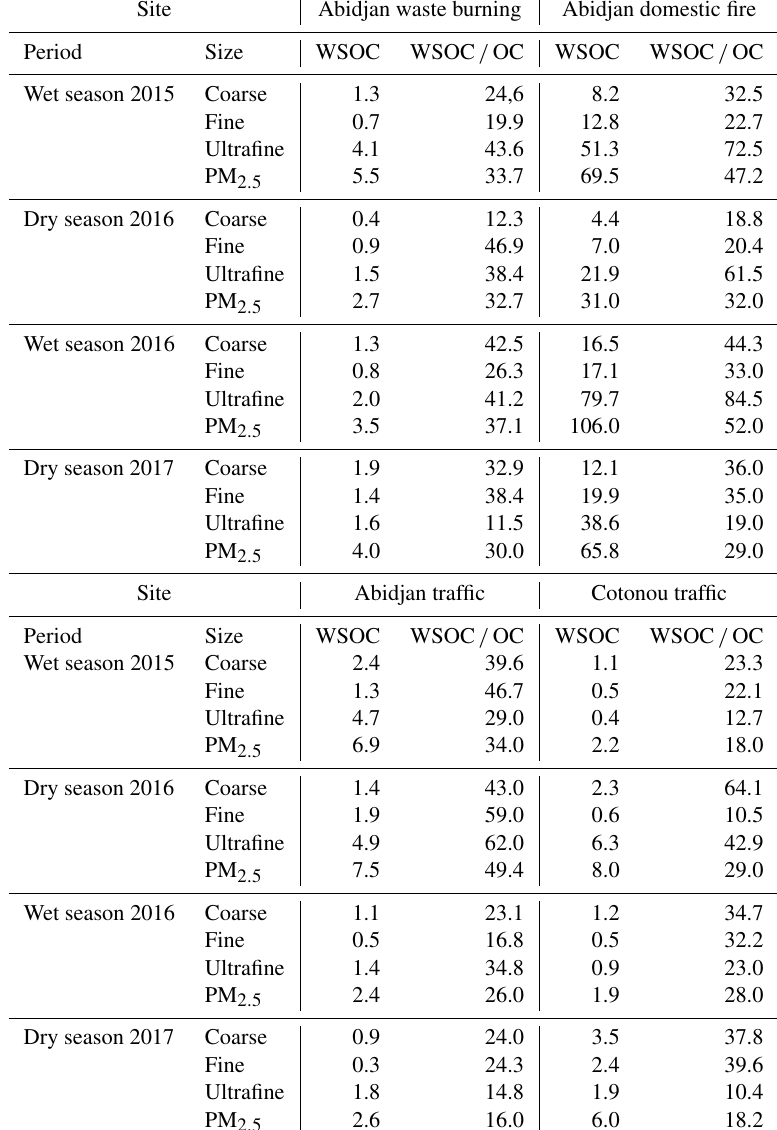
Table 2. WSOC concentrations (µgm − 3 ) and WSOC / OC ratios (%) for each site, each campaign and each aerosol